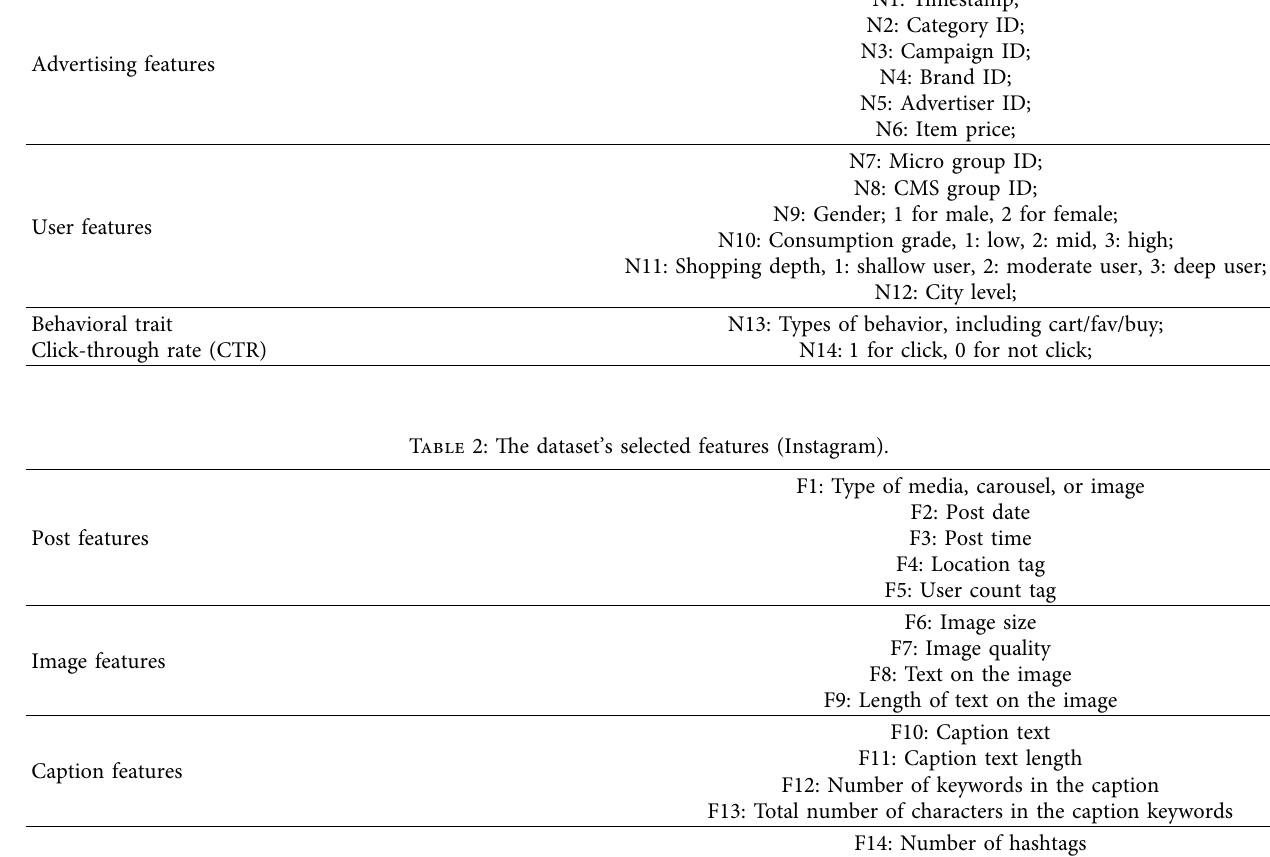
Table 1: The dataset’s selected features (Taobao).